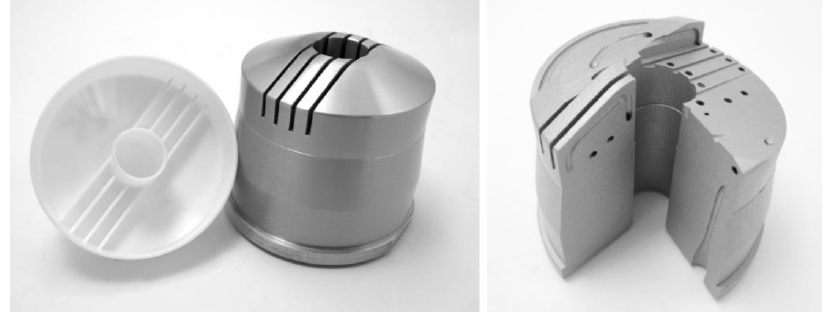
Figure 21. The final manufactured injection molding tool with the principle part ( left ) and sectional part exhibiting the integrated cooling channels ( right ).